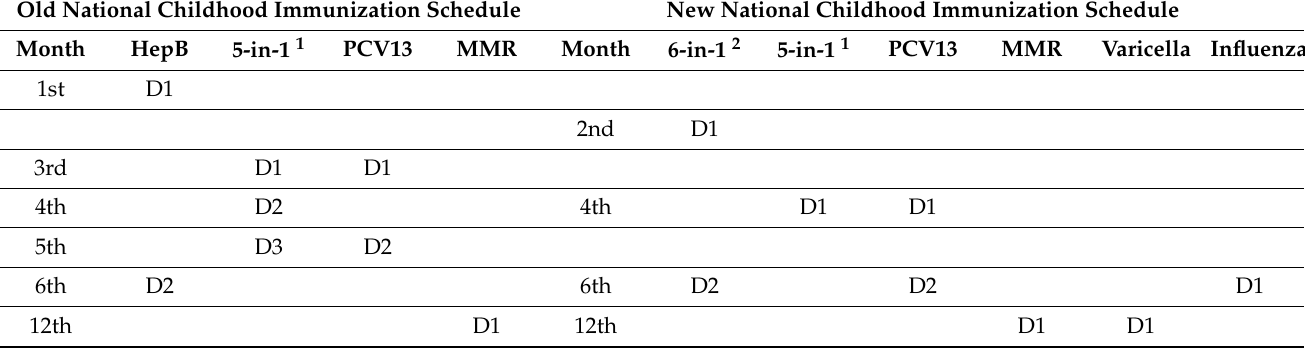
Table 1. Comparison of the “old” and “new” childhood immunization